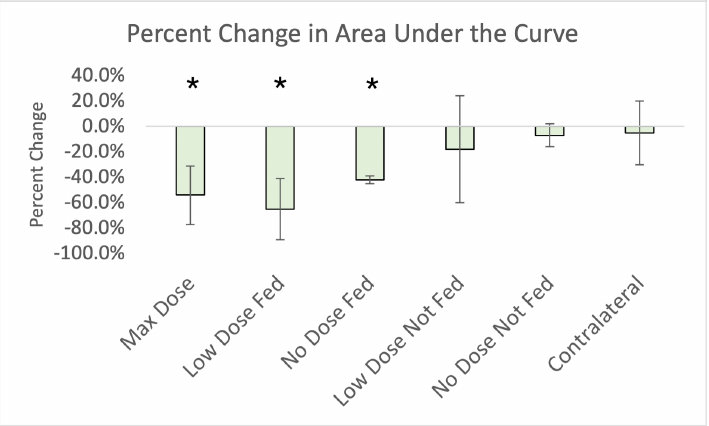
Figure 6. Percent change in area under the curve for each contour analyzed. Each bar represents the average of the 5 subjects (or 4 in the case of the no-dose fed contour). Error bars are the standard deviation of the percent changes in subjects. Statistically significant results are denoted with a